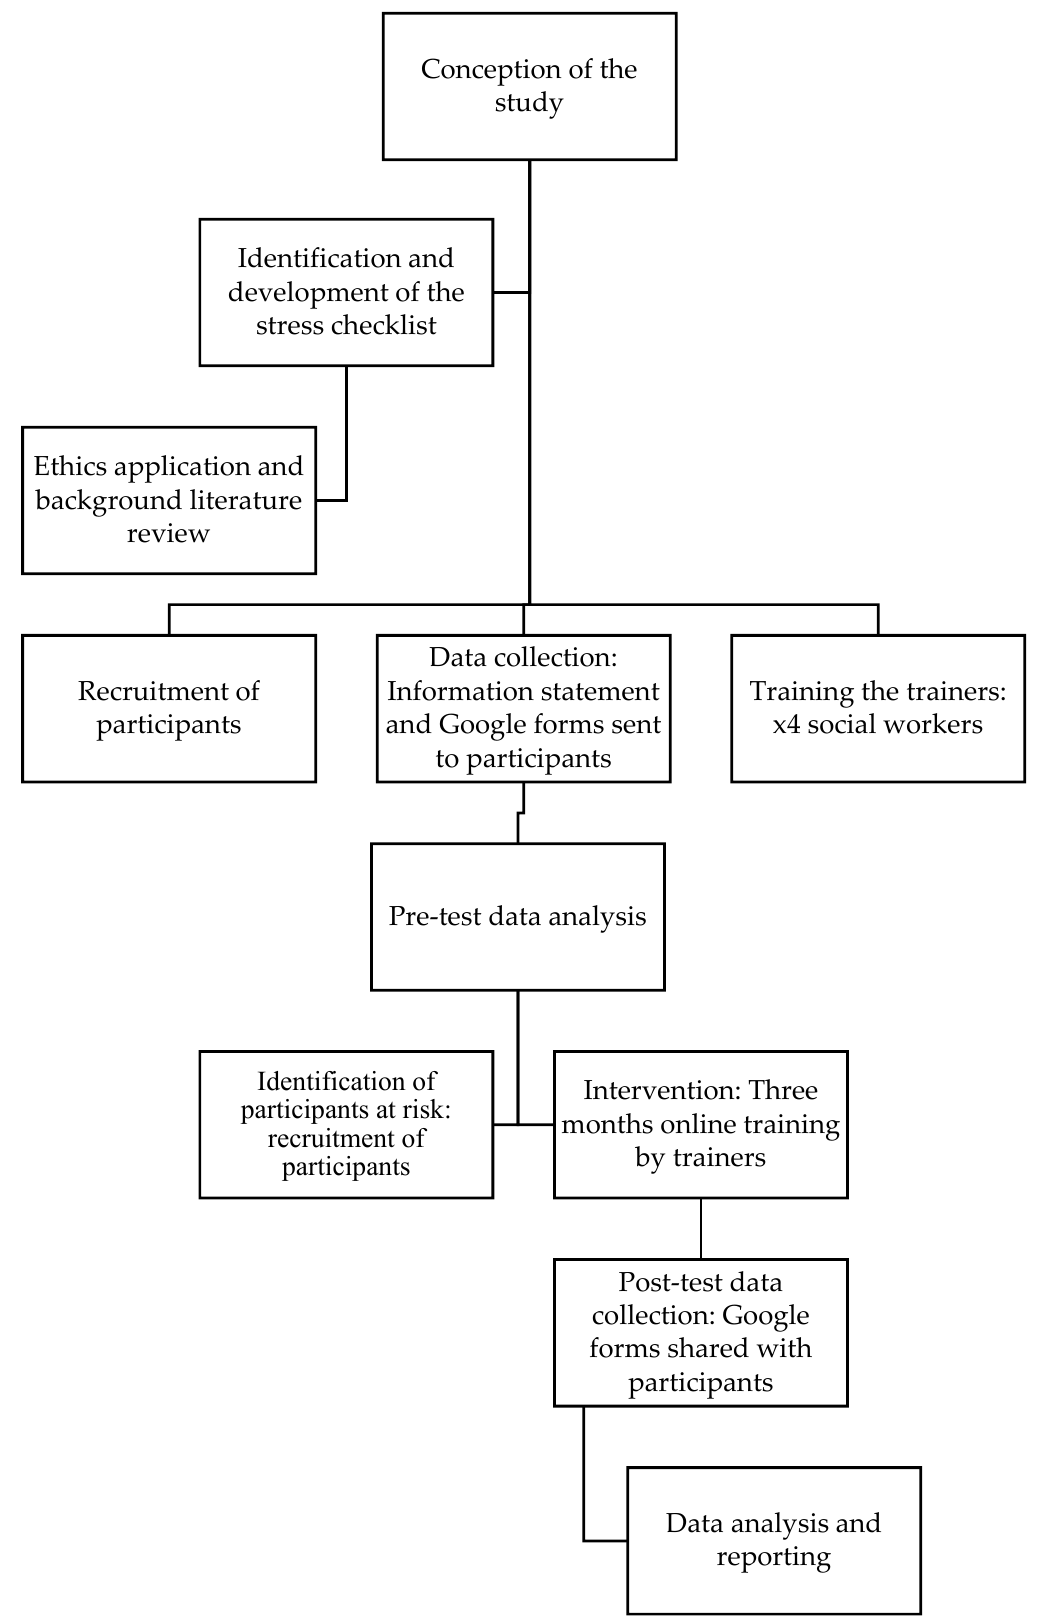
Figure 1. Flow chart of the study design.